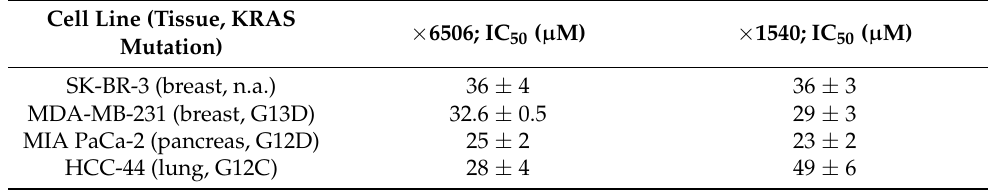
Table 2. Effect of compounds on 2D cell proliferation.